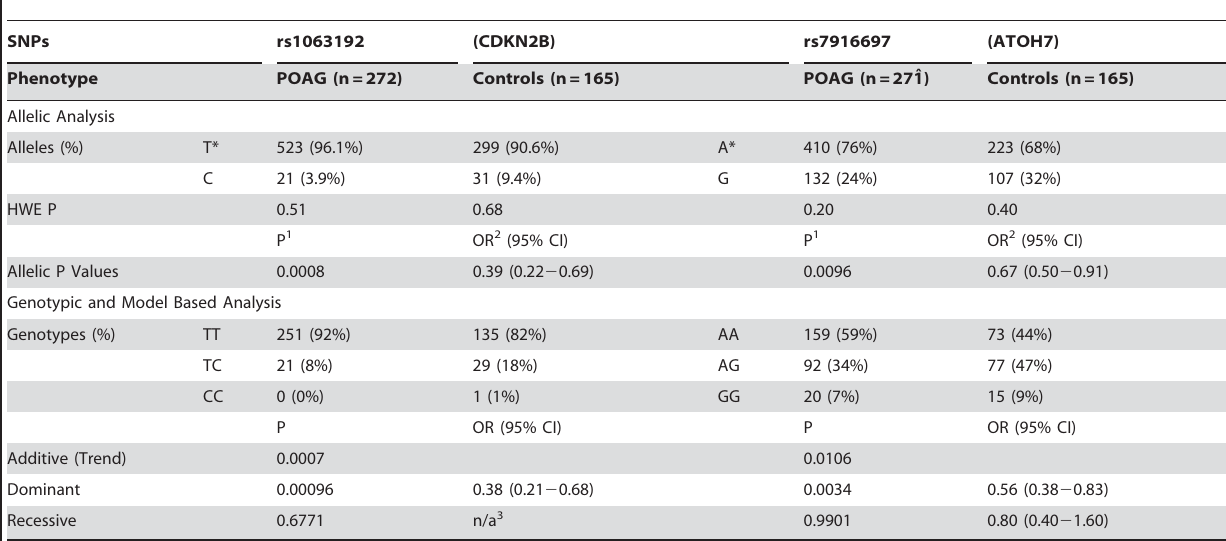
Table 4. Association results of rs1063192 and rs7916697 in different